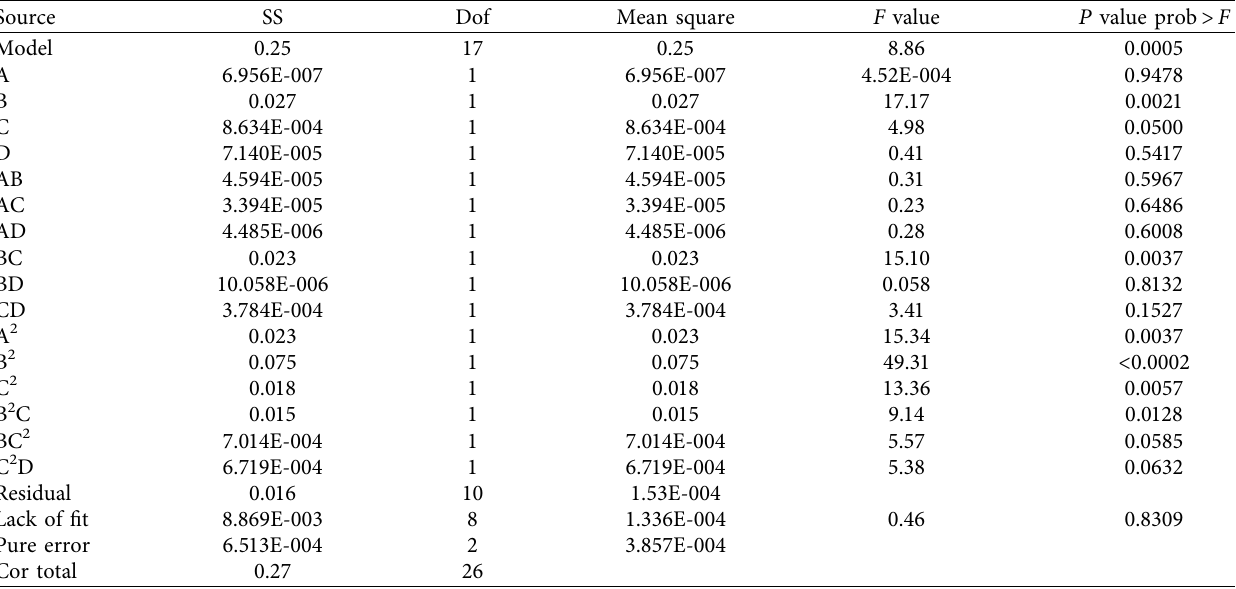
Table 7: Tool wear results on